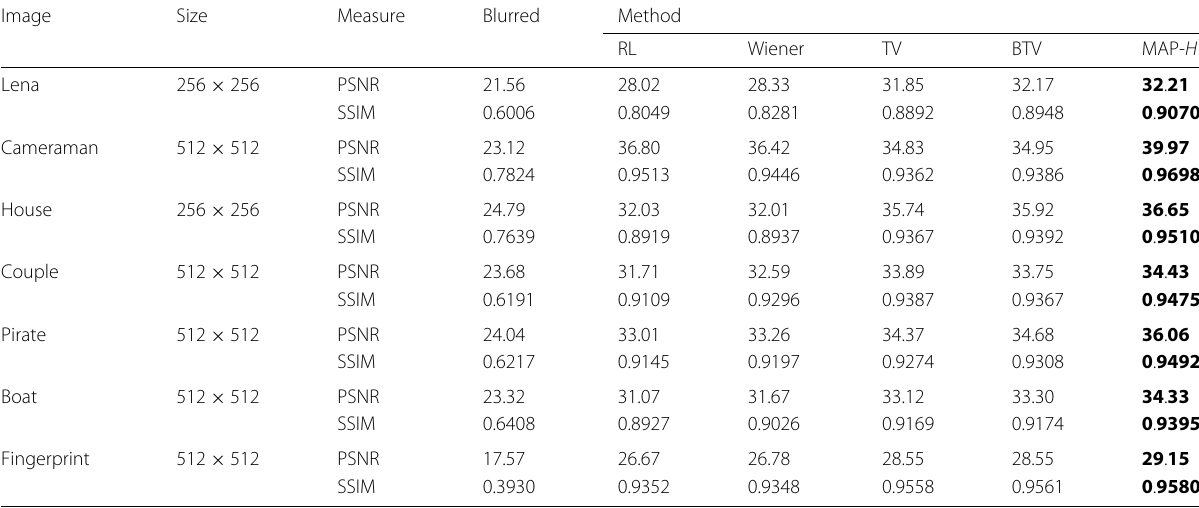
Table 3 PSNR and SSIM values obtained by five methods for seven different images degraded by kernel 3 Image Size